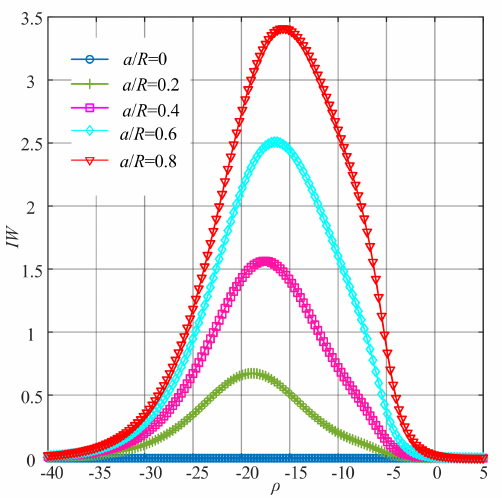
Figure 6. The curves of IW under different crack faults.